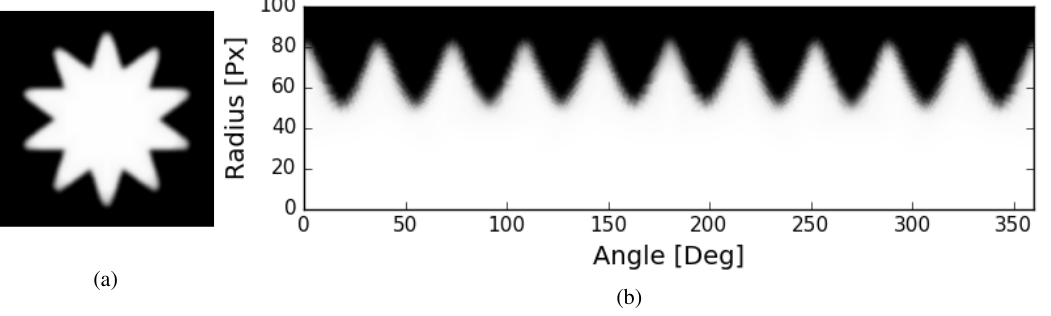
Figure 1: (a) Model of a star-shaped object. (b) Polar shape matrix representation of the